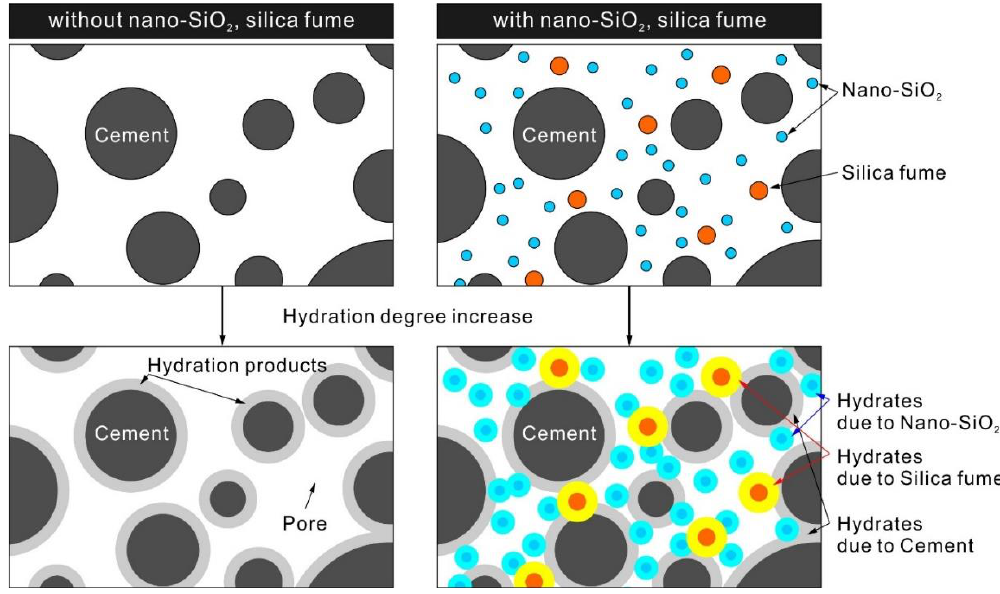
Figure 7. Hydration reaction caused by the NS and SF particles.